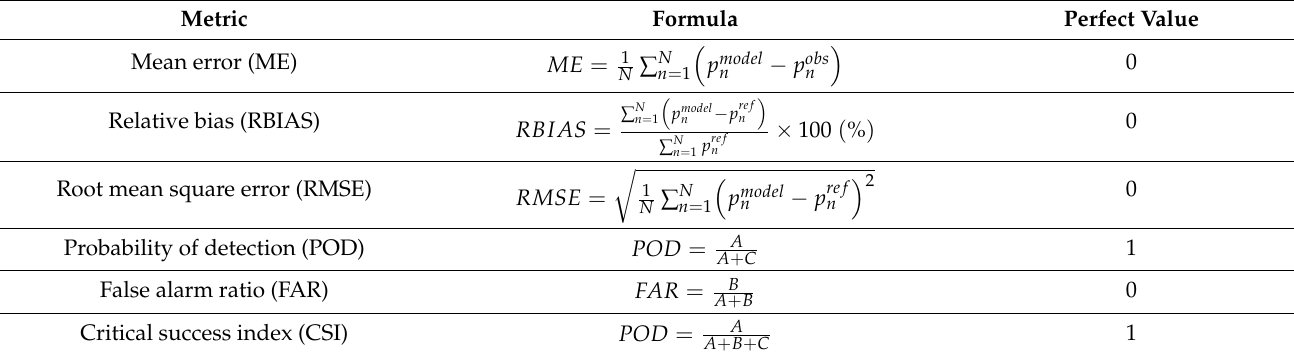
Table 1. Information of error metrics and the contingency